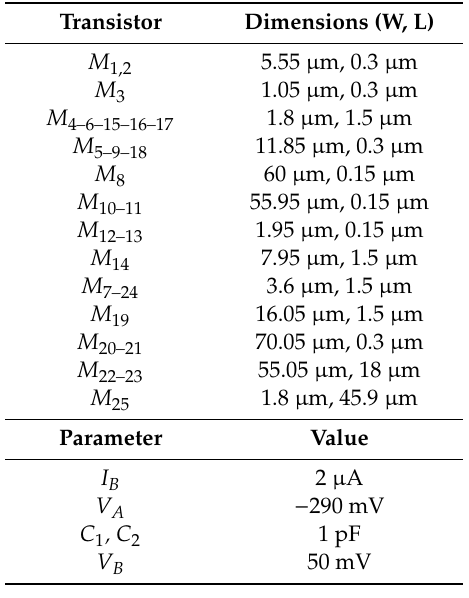
Figure 6. The complete transistor-level architecture of the proposed neural amplifier. The four main blocks have been highlighted: ( 1 ) Biasing current mirror ( 2 ) VCII complete block, ( 3 ) DFVF standalone block, ( 4 ) Voltage Controlled Resistor (VCR). Table 1. Transistor aspect ratios and main parameter